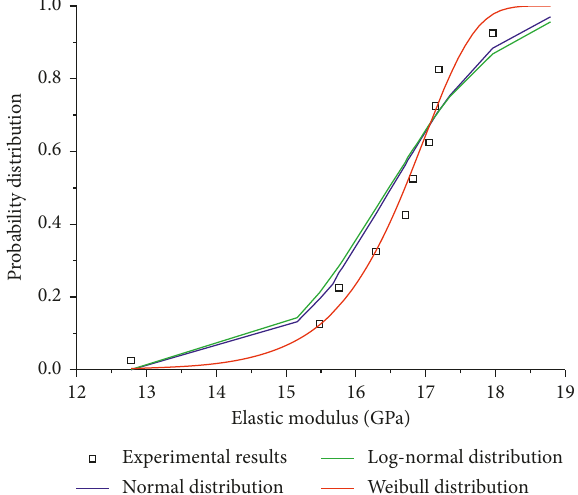
Figure 5: Probability distribution characteristic of the elastic modulus under compression.